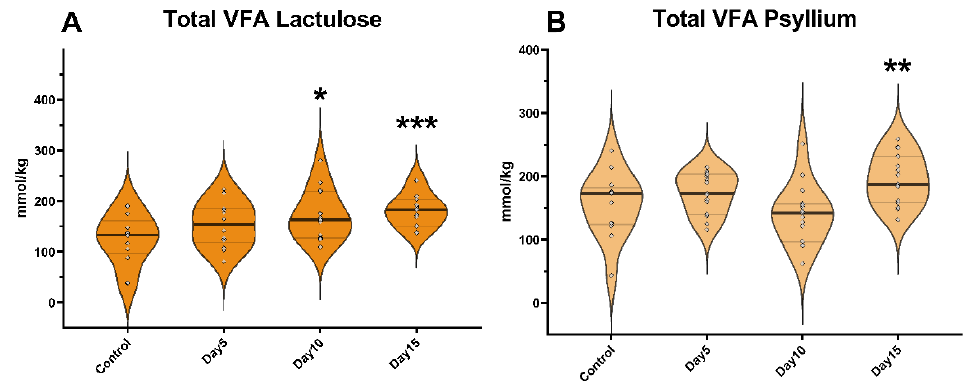
Figure 1. Violin plots show the total volatile fatty acid (VFA) concentration in the fecal samples following lactulose ( A ) and psyllium ( B ) treatment measured by GC-MS method. Data are visualized using violin plots. Concentrations of single samples are plotted as gray dots; black line refers to the median and gray lines refer to first and third quartiles. * p < 0.05, ** p < 0.01, *** p < 0.001.